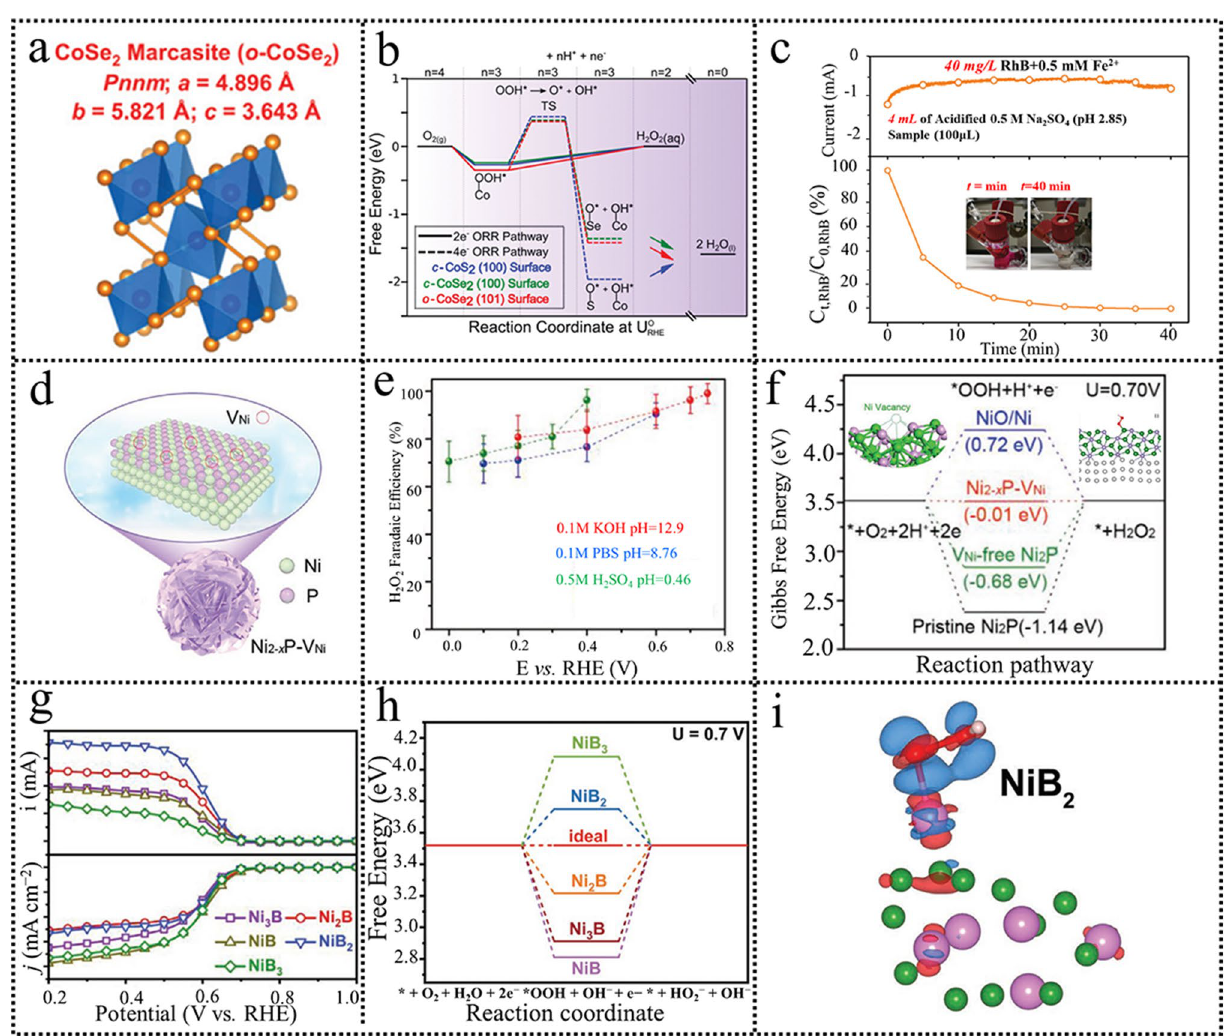
Fig. 9 a Crystal structures, space groups, and lattice constants of o -CoSe 2 . b Calculated free energy diagrams of the 2e − and 4e − ORR path- ways on the c -CoS 2 (100), c -CoSe 2 (100), and o -CoSe 2 . c Chronoamperometry curves of o -CoSe 2 /CFP at 0.5 V ( vs . RHE). Reproduced with permission [99]. Copyright 2020, Royal Society of Chemistry. d Schematic illustration of Ni 2− x P-V Ni . e The Faradaic efficiency of Ni 2−x P-V Ni in various electrolytes. f Free energy diagram of 2e − ORR on all models at 0.70 V. Reproduced with permission [100]. Copyright 2022, Wiley. g LSV curves of the five Ni–B samples. h Free energy diagram for nickel boride clusters. i Charge density distribution of NiB 2. Reproduced with permission [87]. Copyright 2022, Wiley. (Color figure